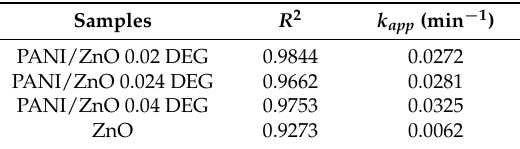
Table 6. Apparent rate constants ( k app ) of dye degradation and linear regression coefficients extracted from ln( c 0 / c t ) − t plots of studied